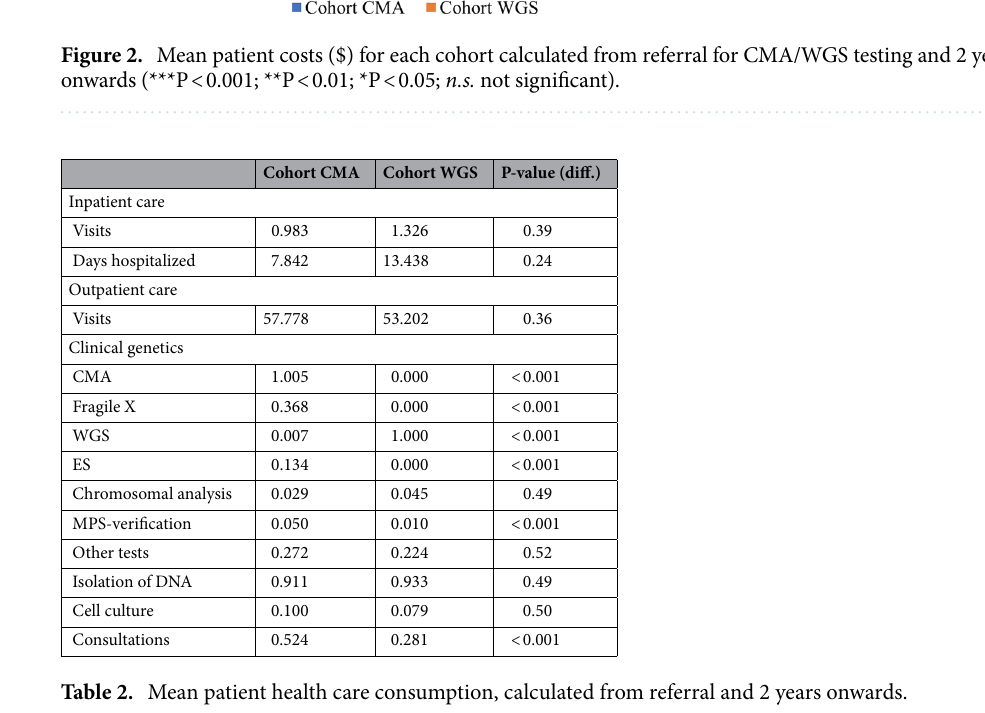
Table 2. Mean patient health care consumption, calculated from referral and 2 years onwards.